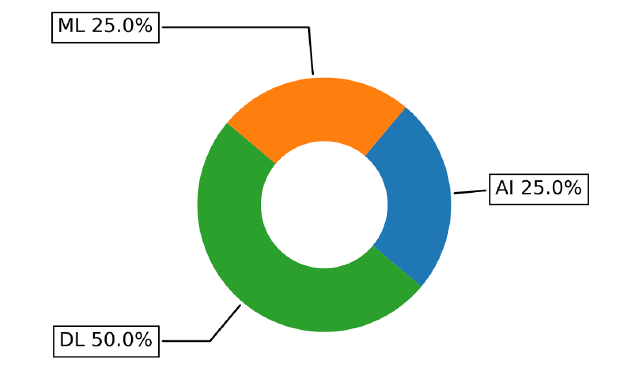
Figure 27. Main AI techniques in logistics addressed by the papers included in the